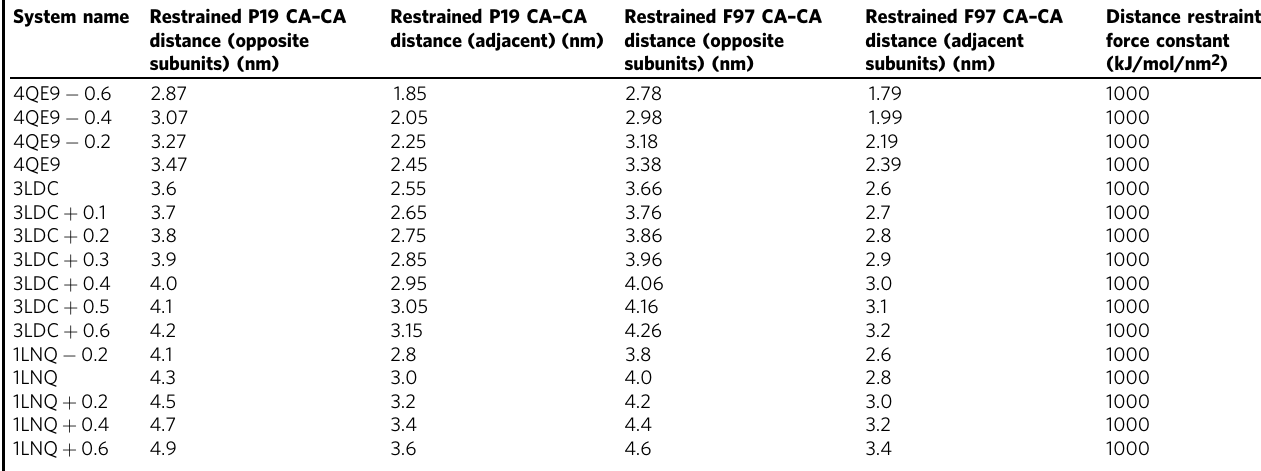
Table 2 List of simulated systems (main set). System name Restrained P19 CA – CA distance